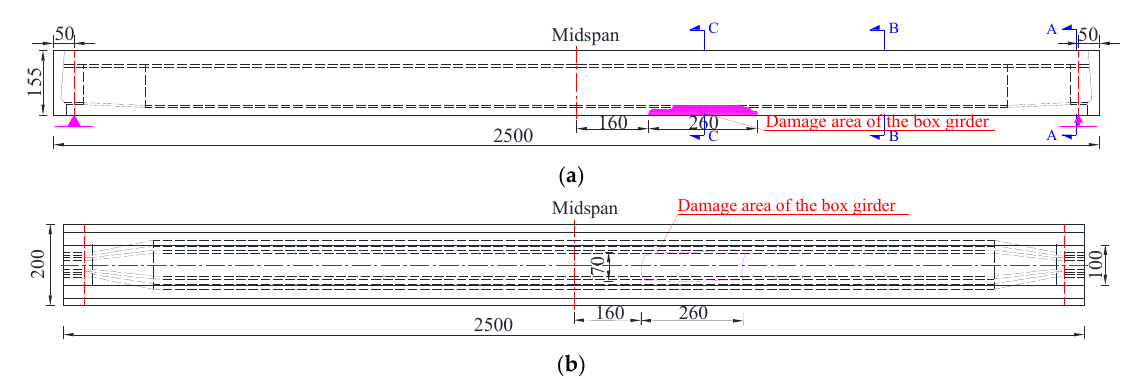
Figure 2. Diseases at the bottom floor of box girder #2 at the fourth span. ( a ) Damaged area; ( b ) Concrete fell off; ( c ) Posttensioned strands and longitudinal steel bars broken.